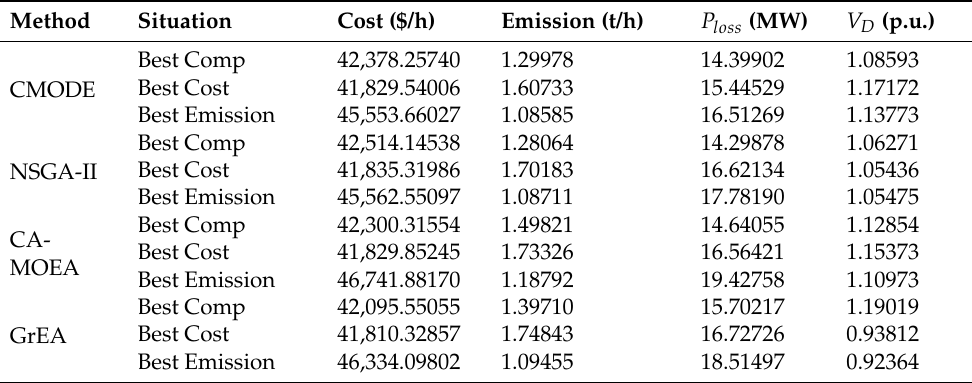
Table 6. The comparison of part of solutions in case 1.